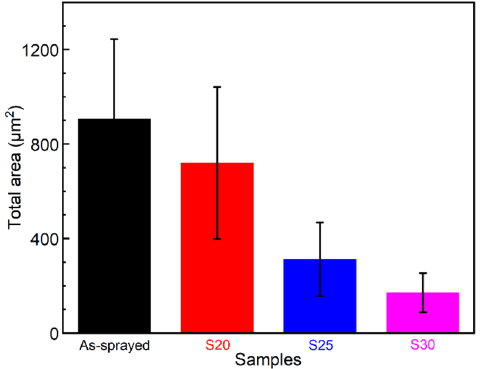
Figure 4. Total areas of interfacial pores for the as-sprayed, S20, S25, and S30 coating samples. S20, S25, and S30 indicate the as-sprayed NiCrBSi coatings remelted at 20 kW, 25 kW, and 30 kW.